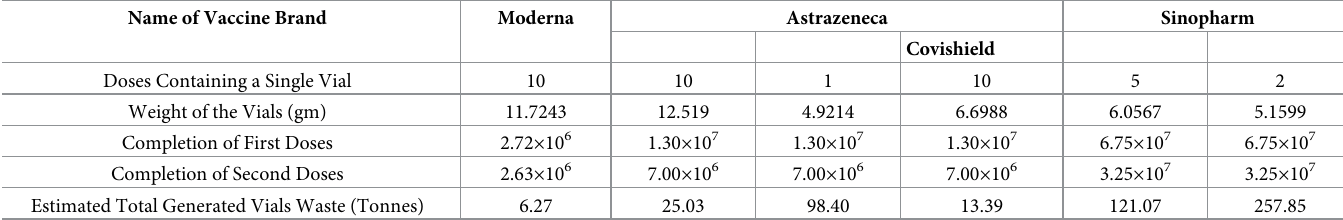
Estimated Total Generated Vials Waste